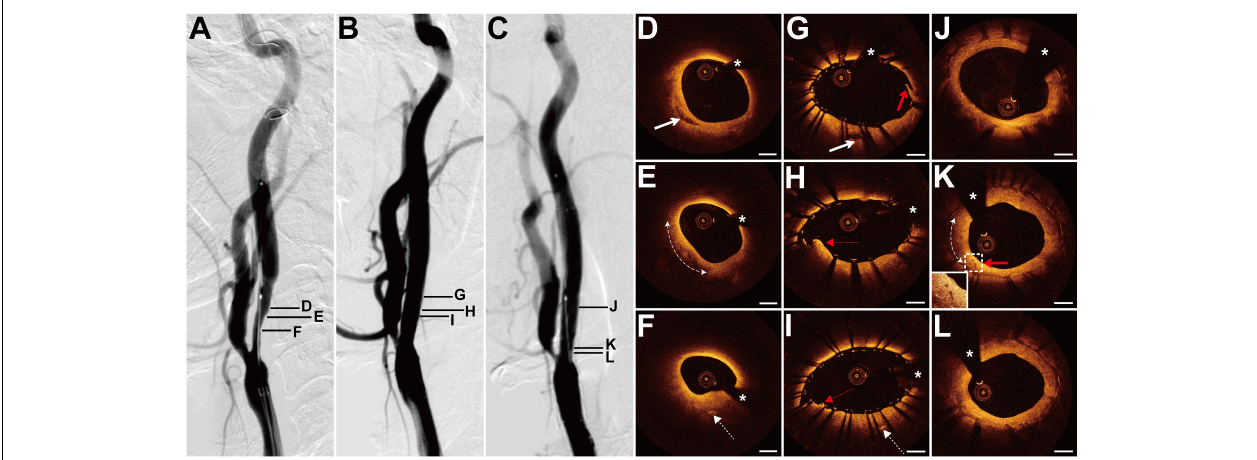
FIGURE 4 | DSA and OCT findings of the RICA lesion. Case 4. (A) The angiogram before stenting showed a long lesion with severe stenosis at the RICA sinus and C1 segment. (B) The angiogram after stenting. (C) The angiogram at a 6-month follow-up revealed no in-stent restenosis. (D) The focal signal-poor tissue (arrow). (E) The lipid-rich plaque (dashed curve with arrows). (F) The image with the minimum lumen. The cholesterol crystals (dashed arrow) at 6 o’clock. (G–I) Post-interventional OCT images. (G) The small dissection (red arrow) at the cross section with the focal signal-poor tissue (arrow). Image (G) corresponds to image (D) . Image (H) represents the image with the minimum lumen. The smooth tissue protrusion (red dashed arrow) between stent struts was detected. (I) The irregular tissue protrusion (red dashed arrow) at the cross section with the cholesterol crystals (dashed arrow) was observed. Image (I) corresponds to image (F) . (J–L) Six-month follow-up OCT images. Image (J) corresponds to image (G) . Image (L) represents the image with the minimum lumen. The homogeneous signal-rich neointima, signal-poor regions around stent struts (dashed curve with arrows), and microvessels (red arrow) were visualized. Scale bars represent 1 mm. Asterisks